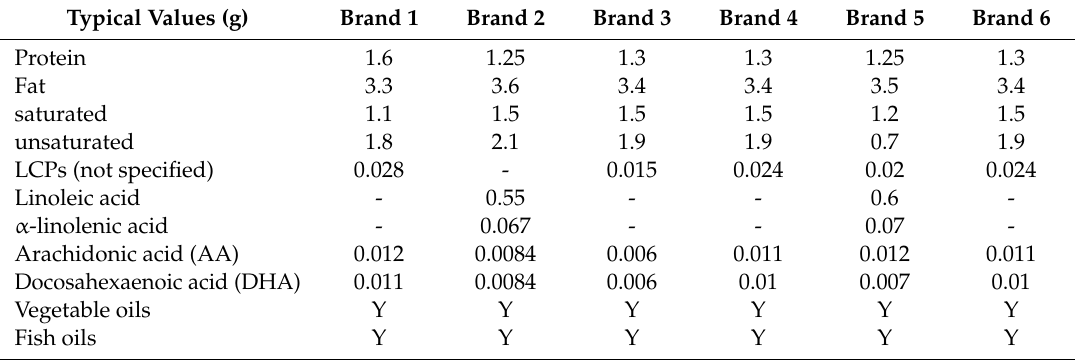
Table 5. Amount (g) / 100 mL of prepared infant milk formula as stated on the product packaging of Brands